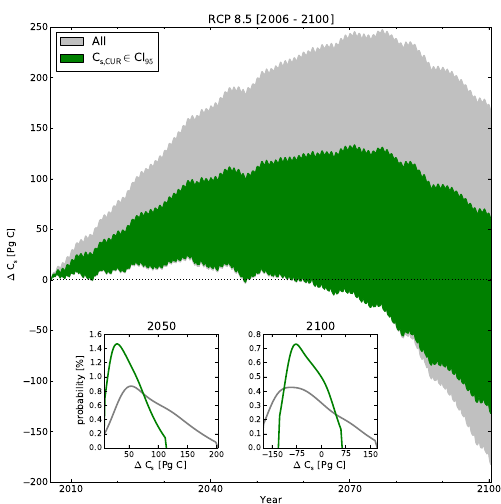
Figure 4. Change in total soil carbon through time for RCP 8.5 projections. Insets represent the probability density function of the change since 2005 for the indicated year. Grey is for all simulations while green is used to distinguish simulations for which total soil carbon is within the CI 95 of the Harmonized World Soil Database in